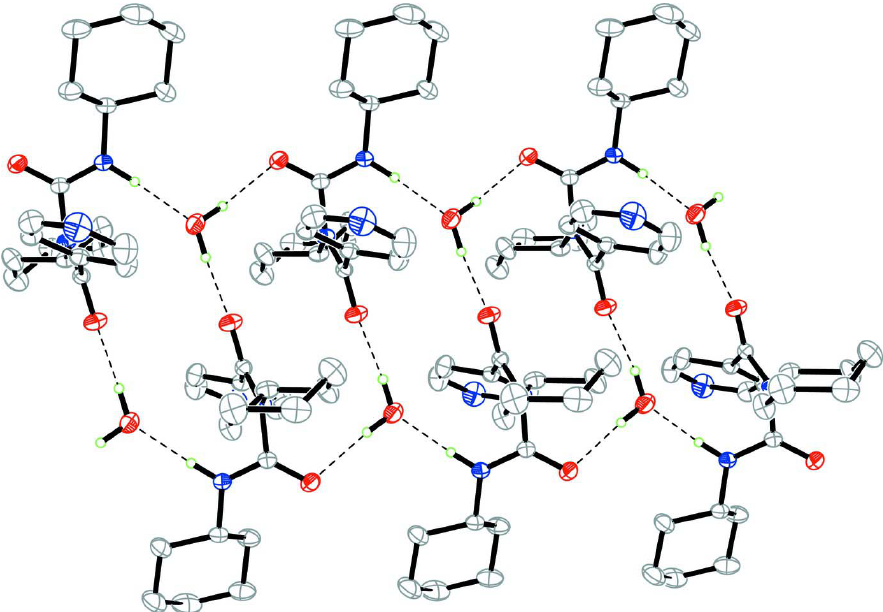
Figure 2 View of the two-dimensional hydrogen-bonded supramolecular